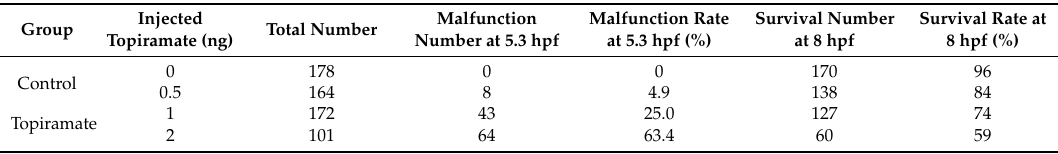
Table 2. Survival and malfunction rate of topirmate-injected embryos. Different dosages of topiramate were injected into embryos and the malfunction and survival rates were monitored. Aberrant epiboly and early death were monitored at 5.3 and 8 hpf, respectively. Embryonic malfunction or survival number/total number of embryos from five different female zebrafish were presented as malfunction and survival